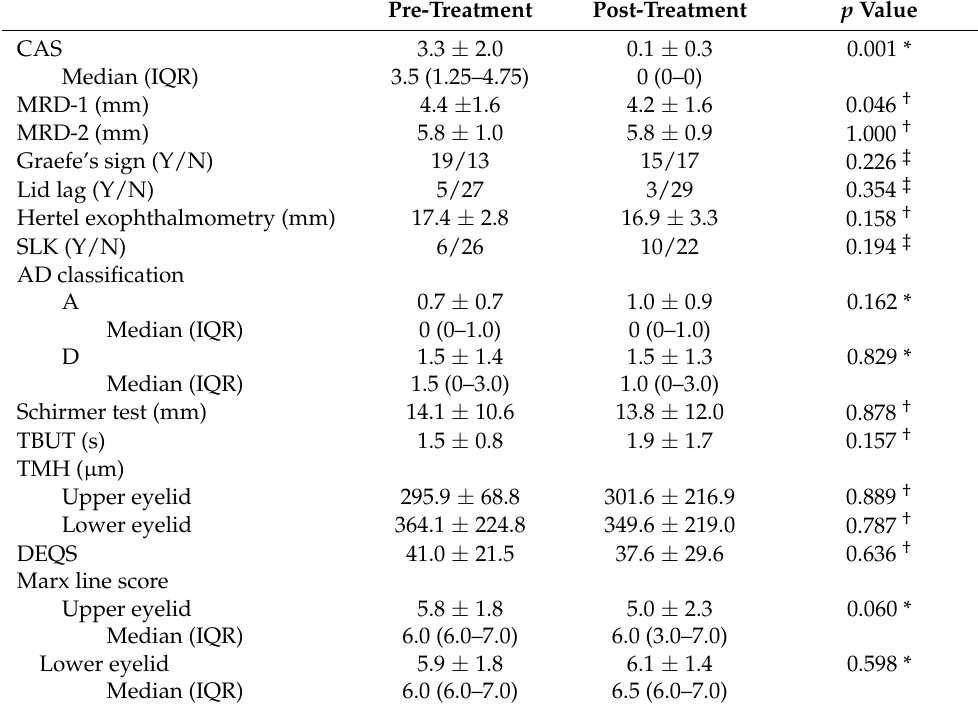
Table 3. Comparison of results measured before and after